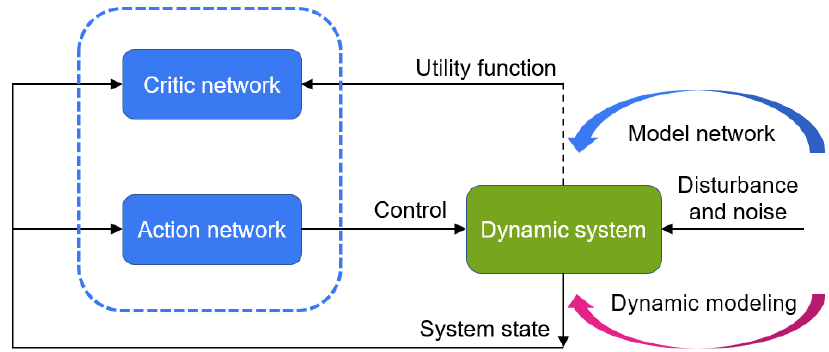
Figure 4. Basic idea of traditional ADP.